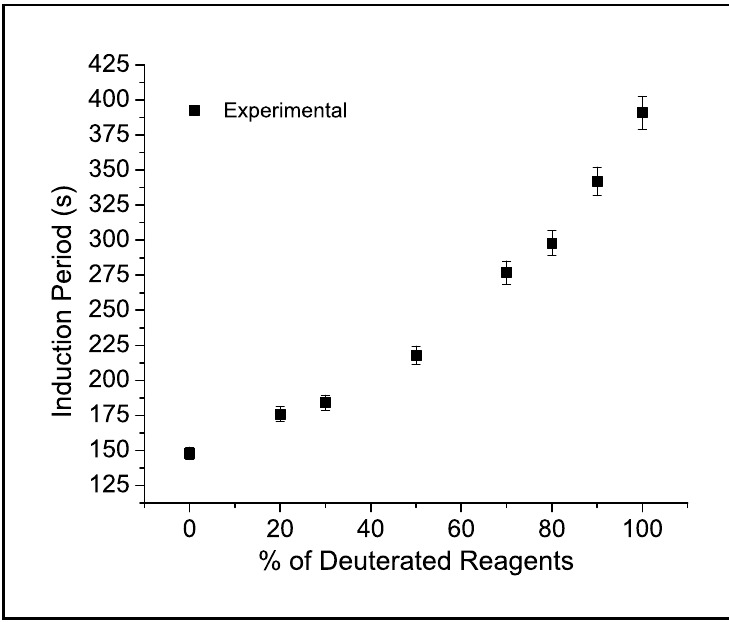
Figure 2. Dependence of Induction Period upon percentage of deuterated reactants at 20 °C for BZ reactions with the following composition [MA] = 0.1 M, [BrO 3- ] = 3 x 10 -2 M, [H